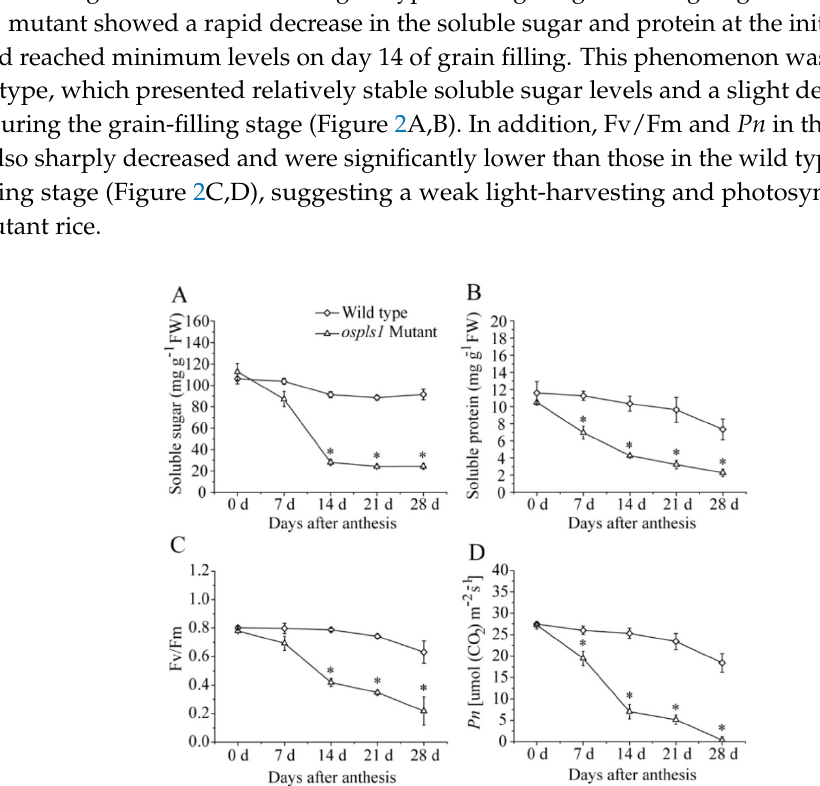
Table 1. Variation of important agronomic traits between ospls1 mutant and wild type. Traits